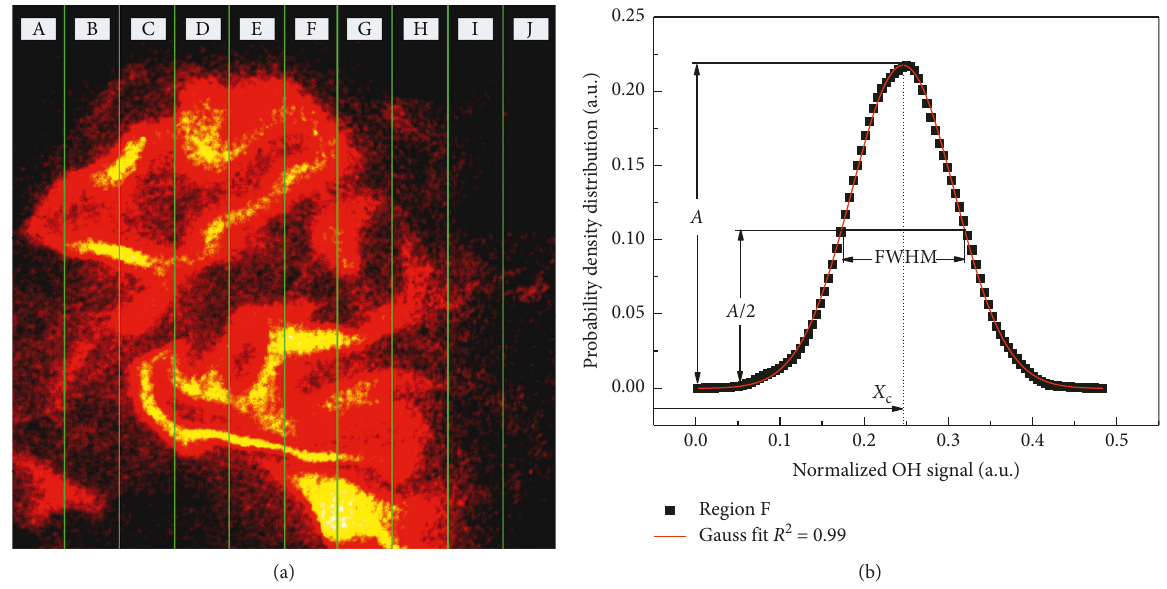
Figure 6: (a) Region segmentation diagram, field of view � 110mm × 110mm. The airflow is from the right to left. The nozzle is on the right. (b) Probability density distribution of oscillation data of the F